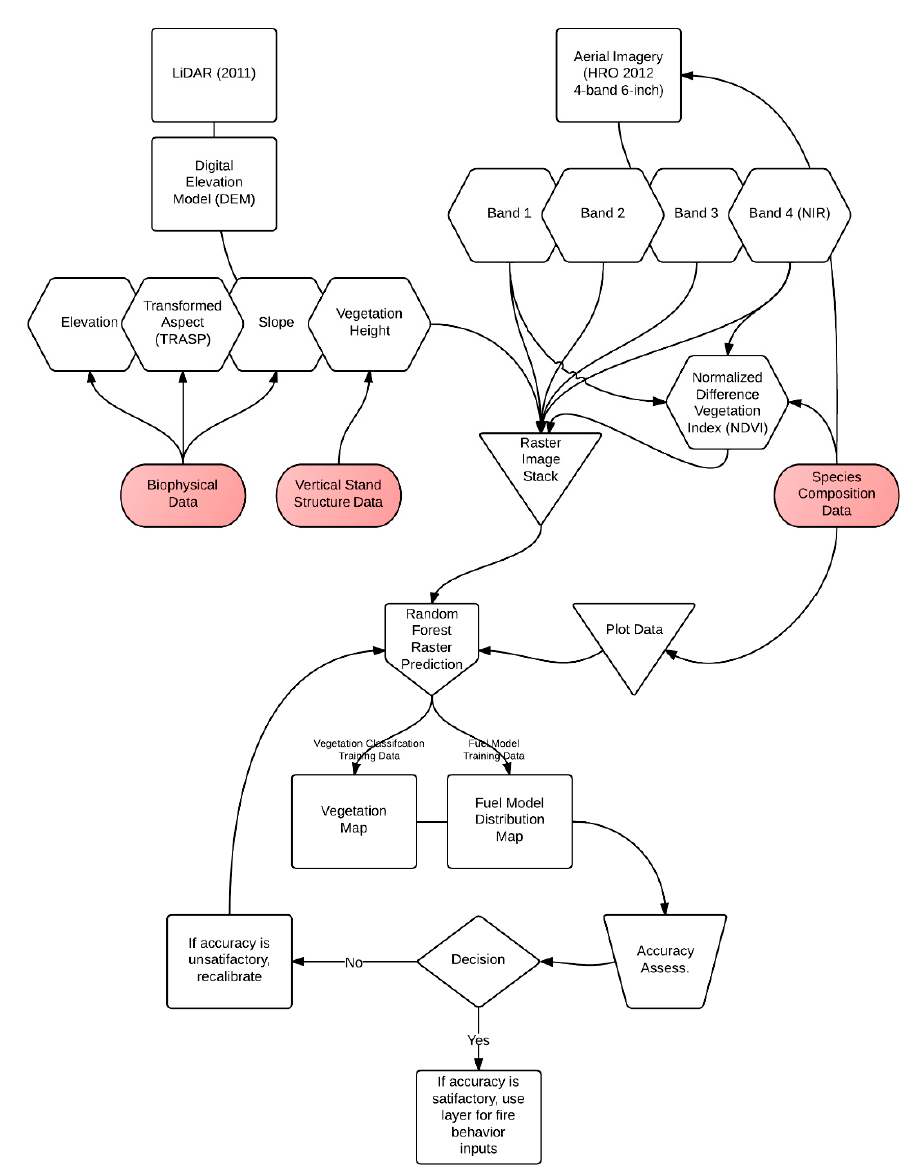
Figure 2. Flow chart of methodology used to map vegetation types and Anderson [32] fire behavior fuel models at Army Garrison Camp Williams. Red boxes indicate the three vegetation triplet categories of [26]. LiDAR = light detection and ranging, HRO = high resolution orthoimagery and NIR = near infrared.